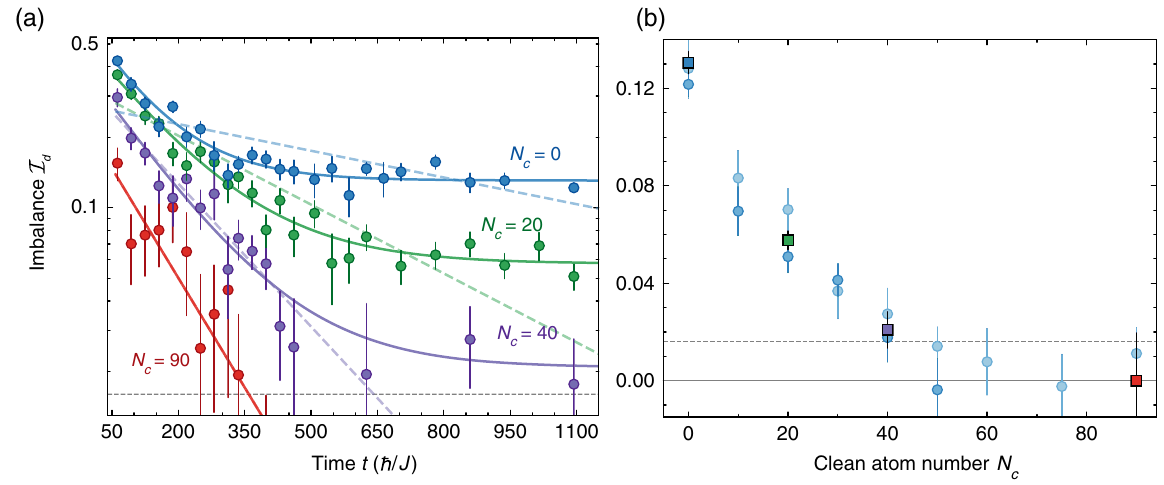
FIG. 3. Dynamics and delocalization in the presence of a quantum bath. (a) Dynamics of the dirty-state imbalance I d for four different bath sizes ( N c ¼ 0 in dark blue, N c ¼ 20 in green, N c ¼ 40 in purple, and N c ¼ 90 in red). The dashed lines indicate exponential fits and the solid lines fits of an exponential with an offset. Introducing the clean component leads to delocalization indicated by the reduced imbalance. The imbalance relaxes completely for the two largest bath sizes, while for the smallest size of the bath ( N c ¼ 20 ), a finite imbalance remains. (b) Experimental steady-state imbalance as a function of the bath size. The data are measured at t ¼ 859 τ (round points in blue) and at t ¼ 1094 τ (round points in light blue). The square points correspond to the asymptotic offsets obtained from the four solid line fits in (a). The horizontal dashed gray line indicates the typical statistical threshold at which the imbalance is compatible with zero. The error bars indicate 1 standard deviation of the